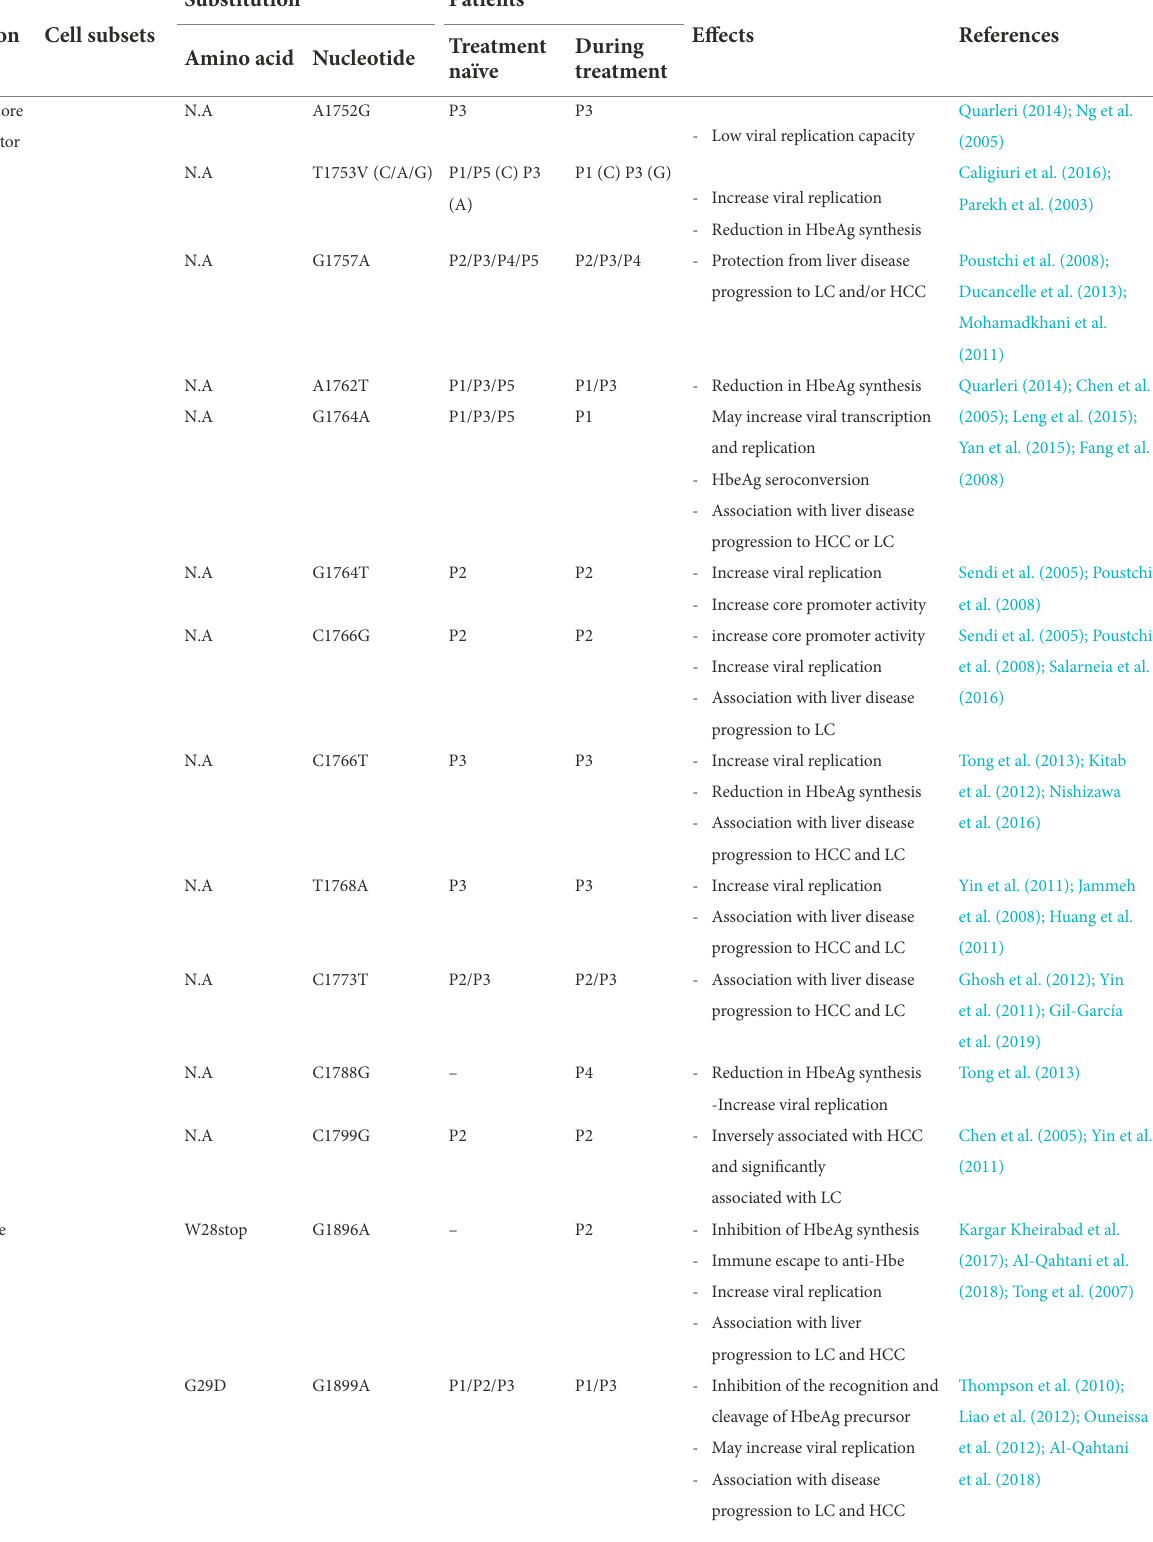
TABLE 4 Amino acid/nucleotide substitutions detected within the BCP, recure, and core sequences of the five chronic HBV infected patients with their impact.